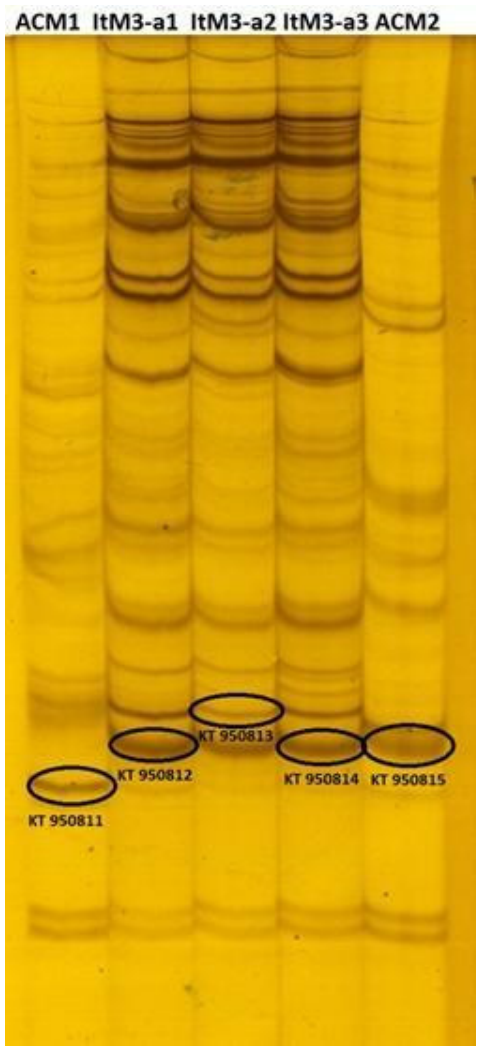
Figure 3. PCR–SSCP patterns obtained from a region of the 28S-rDNA gene of AMF indigenous to the Argentine Puna belonging to Funneliformis genus. References: AC: Abra del Cóndor; It: Iturbe; M1, M2, M3: multiplication cycles 1, 2 and 3, respectively. Bands marked with ovals were cut and sequenced. Access numbers of the sequences are shown on Figure 4.